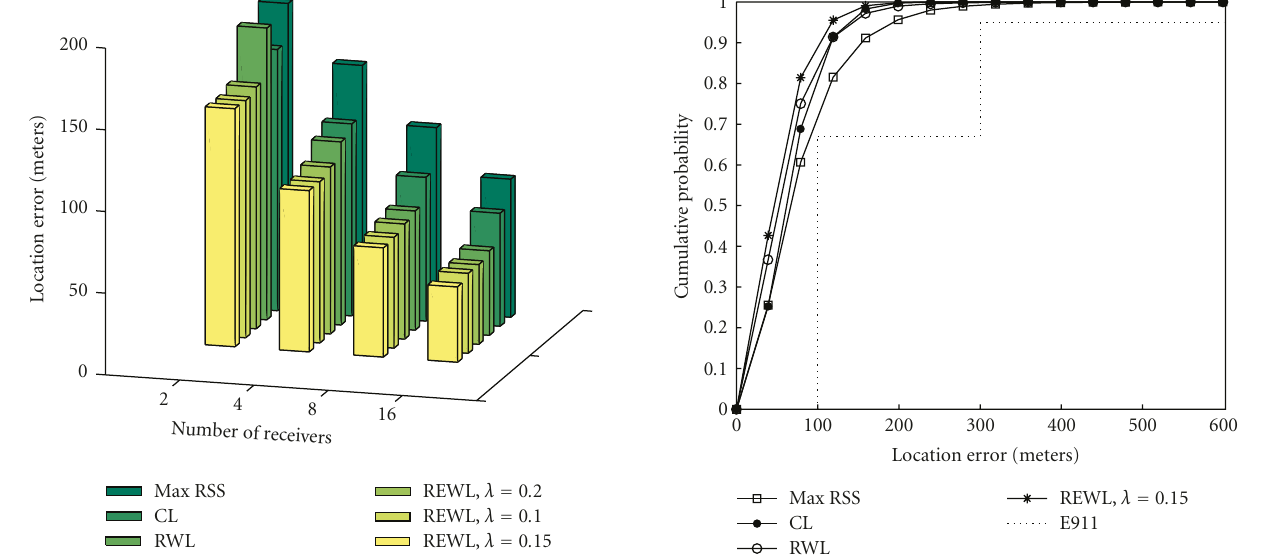
Figure 8: Algorithm location error CDF for four receivers at 2.4GHz.